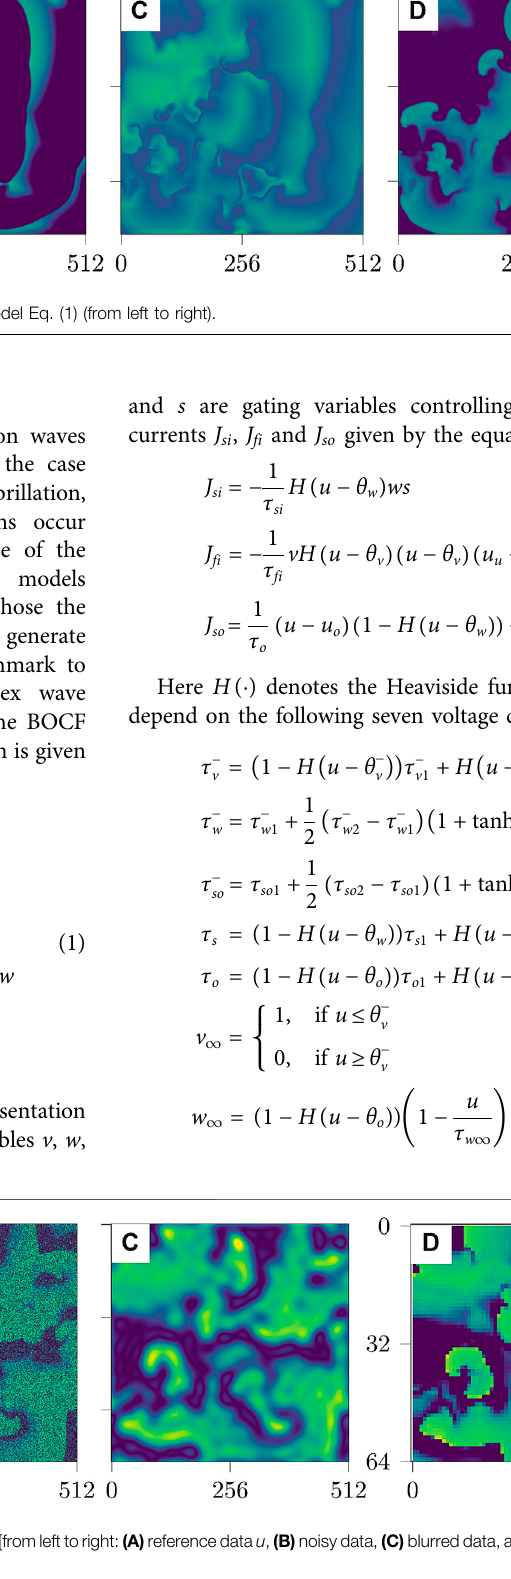
Frontiers in Applied Mathematics and Statistics |